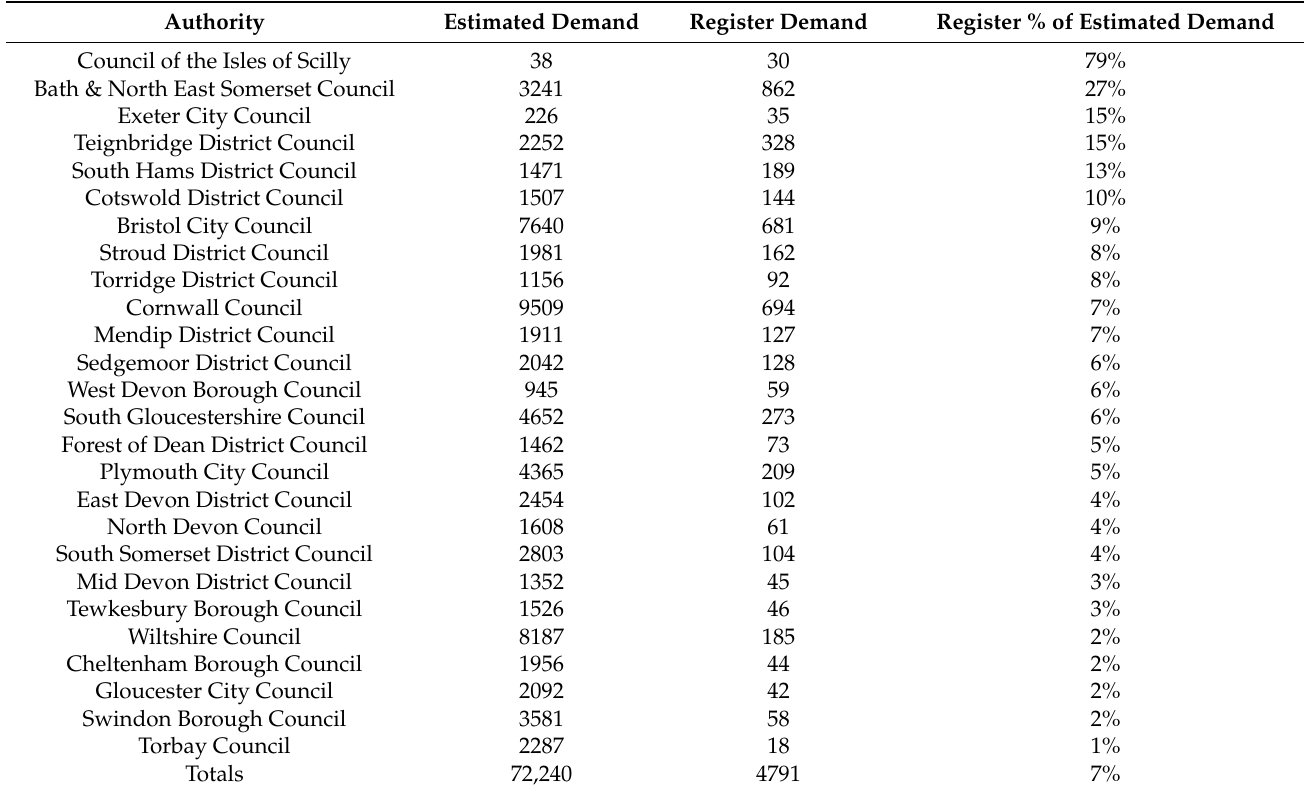
Table 9. Estimated demand across the study area using national data compared with demand recorded on